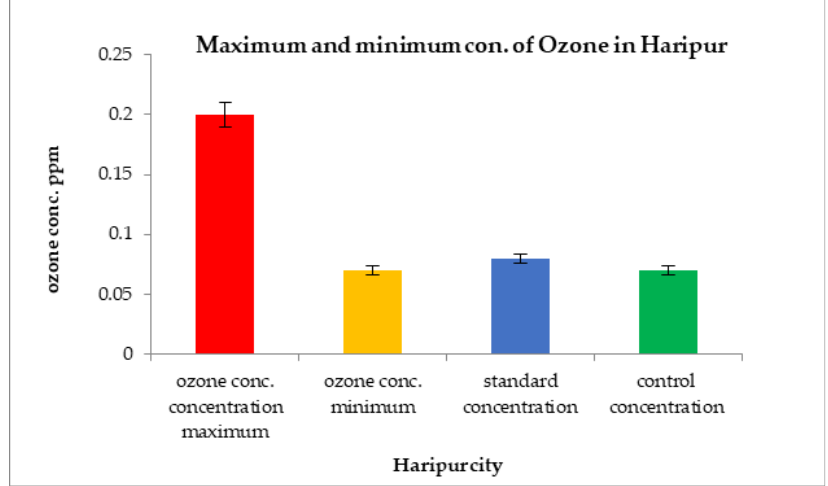
Figure 11. Comparison of maximum and minimum ozone concentrations with control sites and WHO standard values in Haripur.